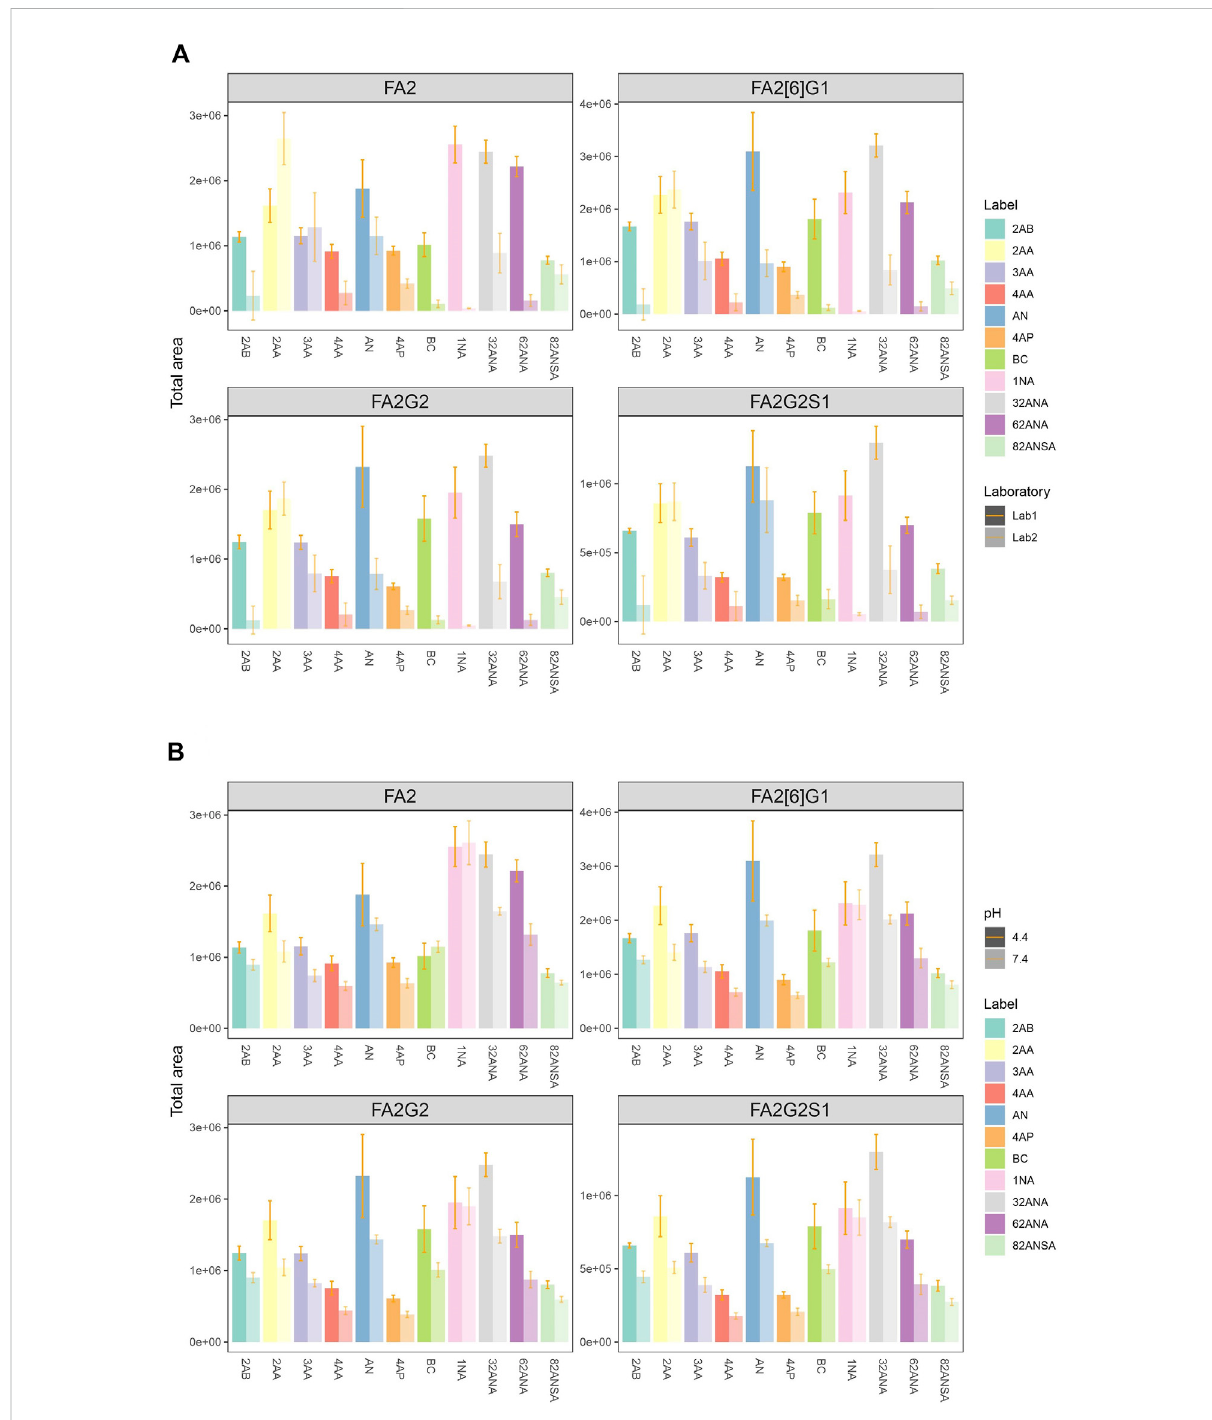
FIGURE 1 (A) Comparison of total area of all labels integrated for 4 most intensive peaks in two laboratories at pH 4.4. (B) Comparison of total area of all labels integrated for 4 most intensive peaks at pH 4.4 and 7.4 in the same laboratory (Lab1). Error bars represent the standard deviation of pentaplicates